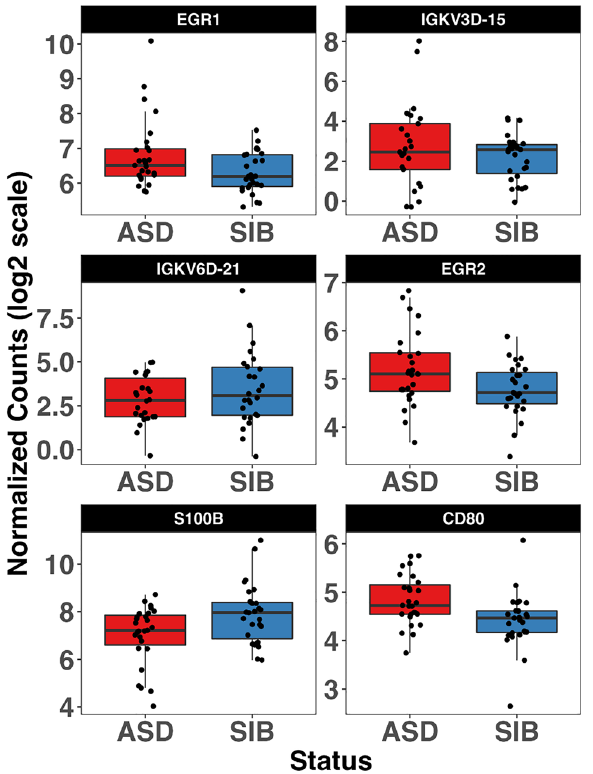
Figure 2. Boxplot of the top six differentially-expressed genes detected using the unpaired model. EGR1 and IGKV3D-15 retain significant p values after FDR correction (both p adj = 0.037).